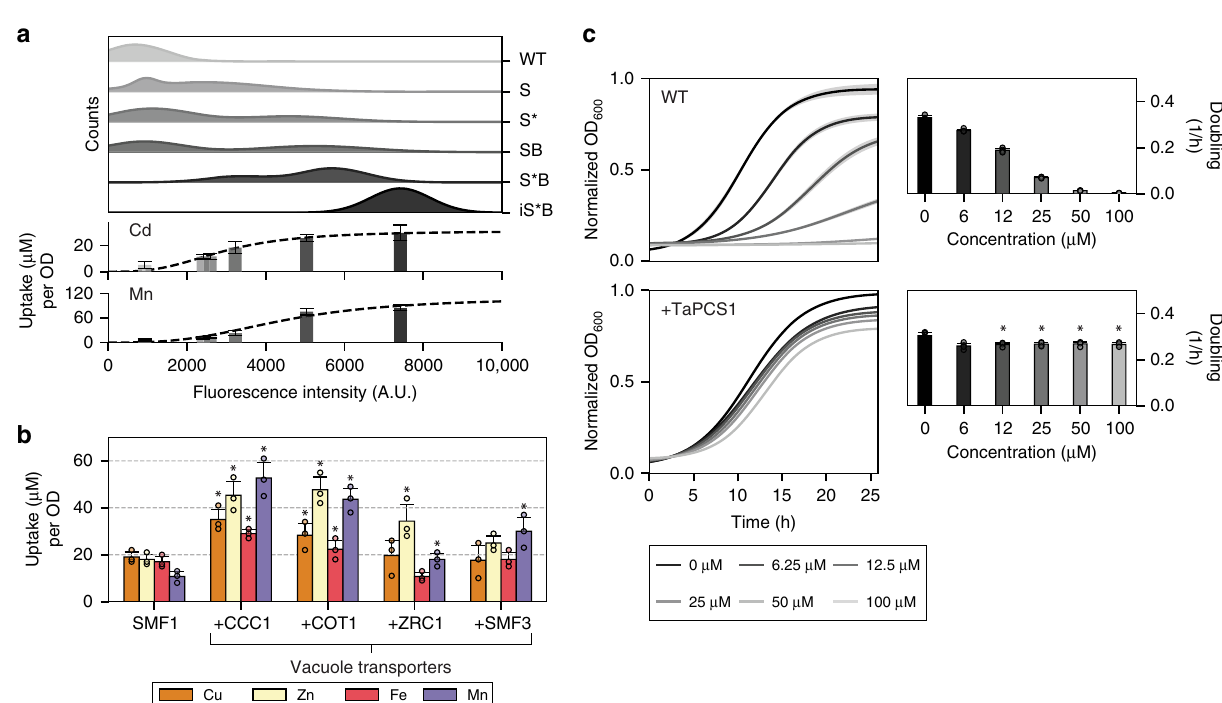
Fig. 2 Modifying yeast metal traf fi cking pathways improved metal uptake and tolerance. a Top subpanel shows the population distribution of SMF1 variants measured with fl uorescently labeled V5-tag using fl ow cytometry. The weighted average of the fl uorescent intensity corresponds to the placement of the lower subpanel bar charts which represent the level of metal uptake for that strain. Increasing expression levels of SMF1 correlated to increased metal uptake of cadmium or manganese; however, up to a certain point indicated by the plateau in uptake. b Expression of vacuole transporters CCC1, COT1, ZRC1, and SMF3 in addition to SMF1 enhanced metal uptake. Asterisk above bar charts represent signi fi cant increase in uptake compared to SMF1 ( p < 0.05). c Constitutively expressing wheat phytochelatin synthase, TaPCS1, conferred heavy metal tolerance against cadmium. Asterisk above bar charts represent signi fi cant changes in growth rates compared to WT ( p < 0.01). For all data, the mean ± s.d. of three replicates are shown. The source